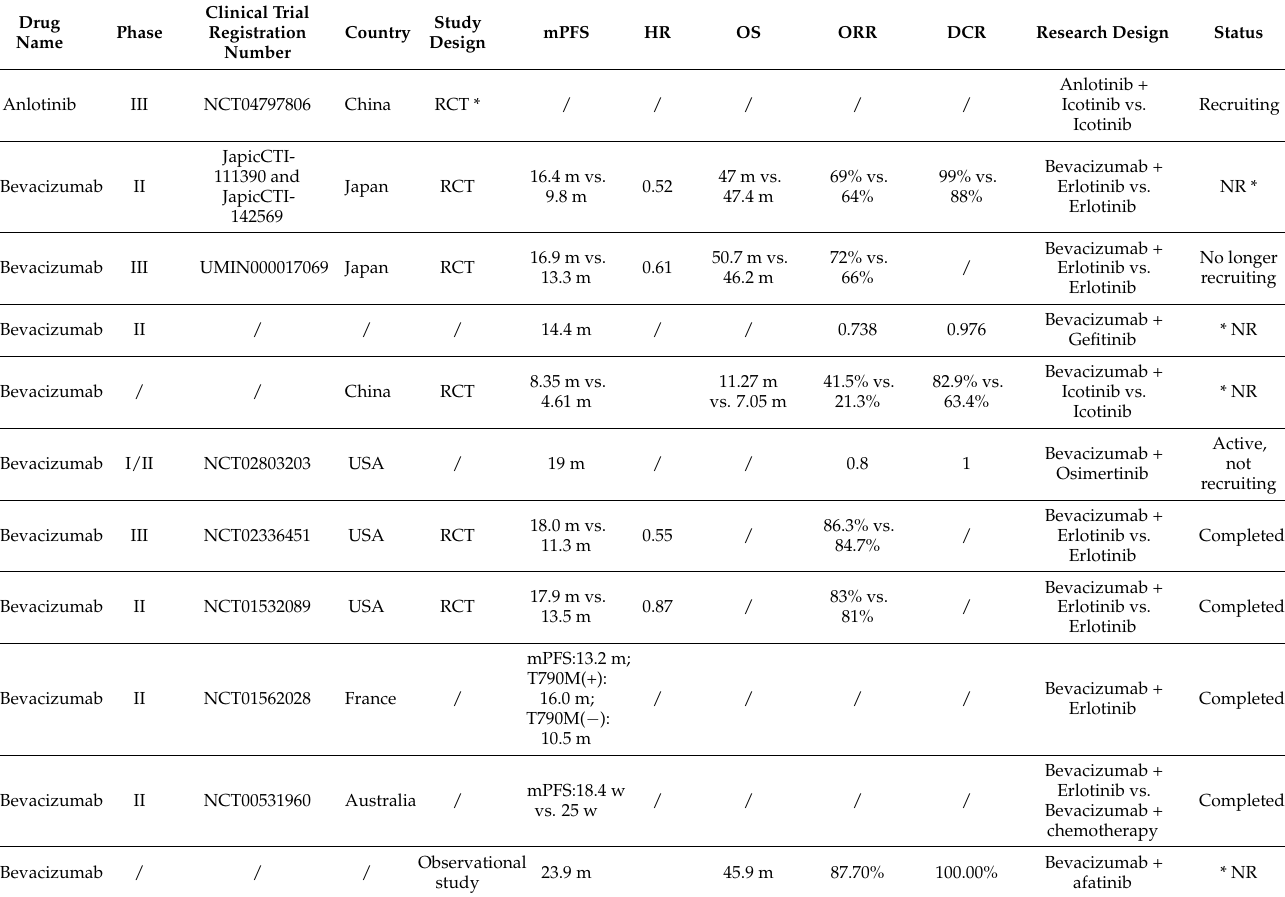
Table 2. Clinical trials of the combination of EGFR-TKIs and antiangiogenics after resistance to first-/second-generation